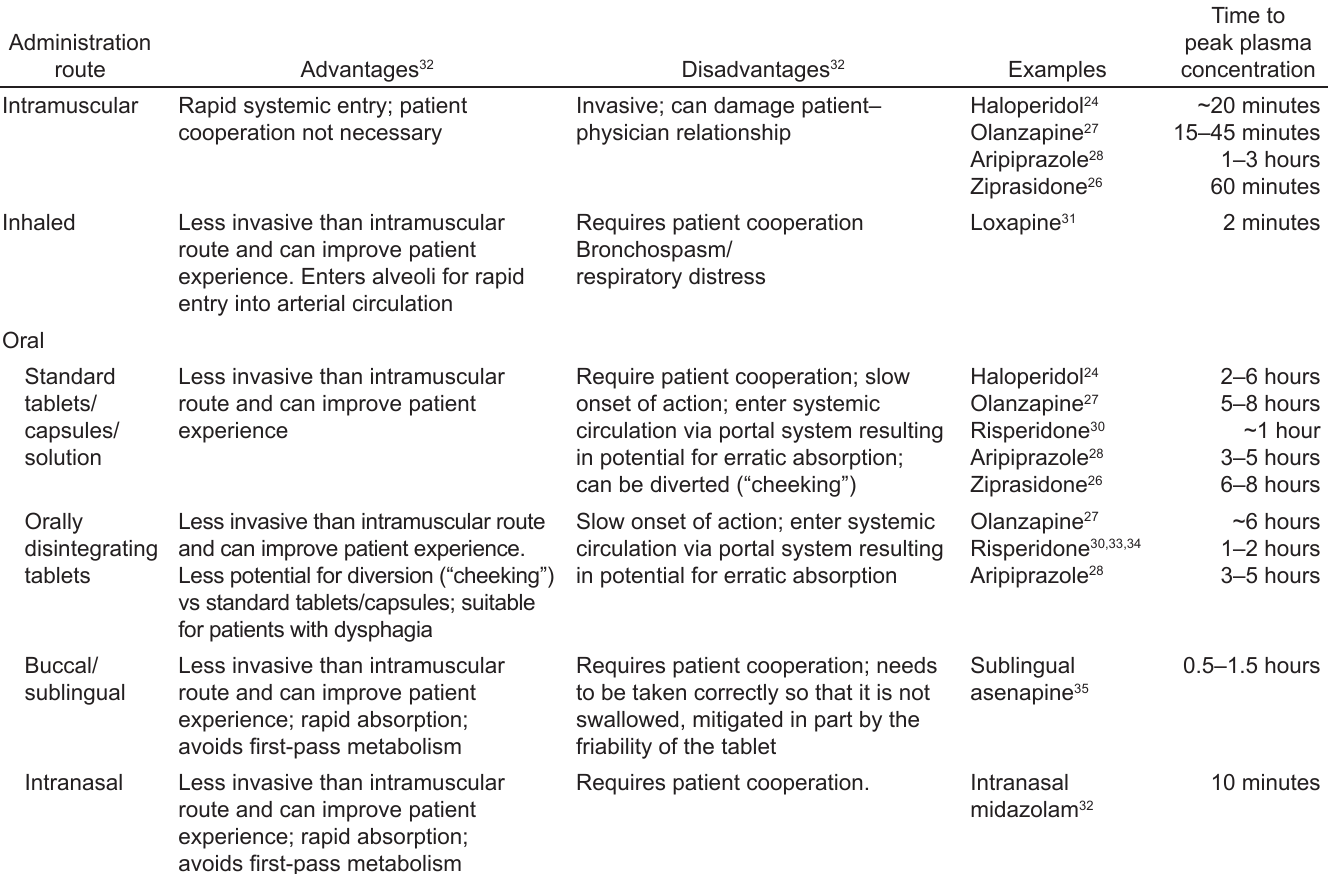
Table 3. Advantages and disadvantages of different routes of